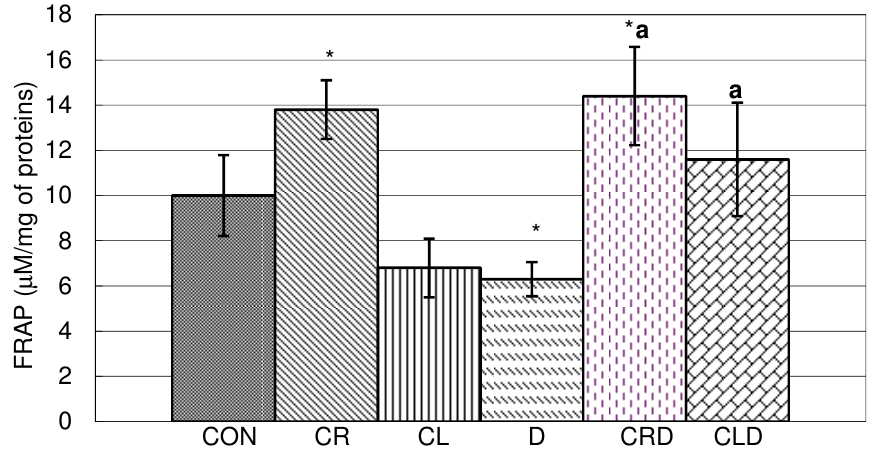
Figure 3. Effects of doxorubicin, celery leaf and root juices and their combination on FRAP antioxidant capacities in liver homogenate. t-test, n =   6; compared to CON group: * p < 0.05, compared to D group: a p < 0.05.